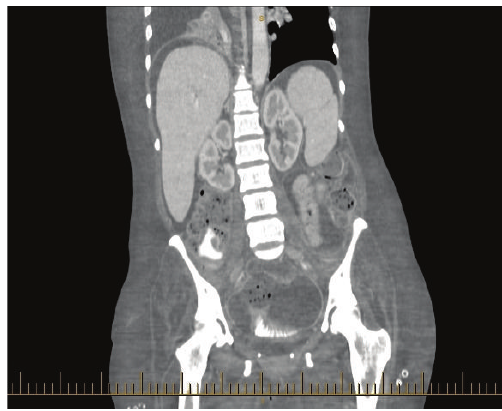
Figure 2: CT scan showing rectosigmoid out-pouching.